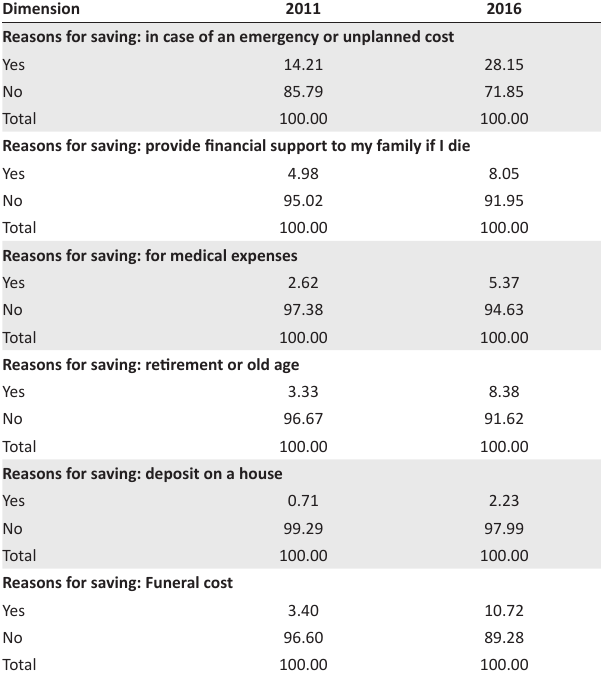
TABLE 8-A1: Description of data on the planning dimension of financial health ( % ).